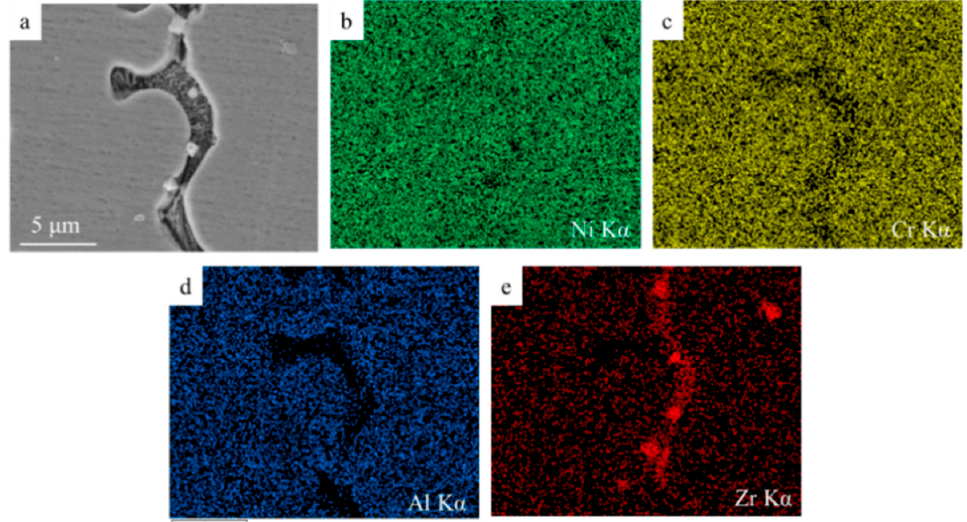
Figure 6. Elements distribution map of 20% ZrO 2 sample: ( a ) microstructure of 20% ZrO 2 sample, ( b – e ) element surface scan results for region ( a ). ( b – e ) element surface scan results for region ( a